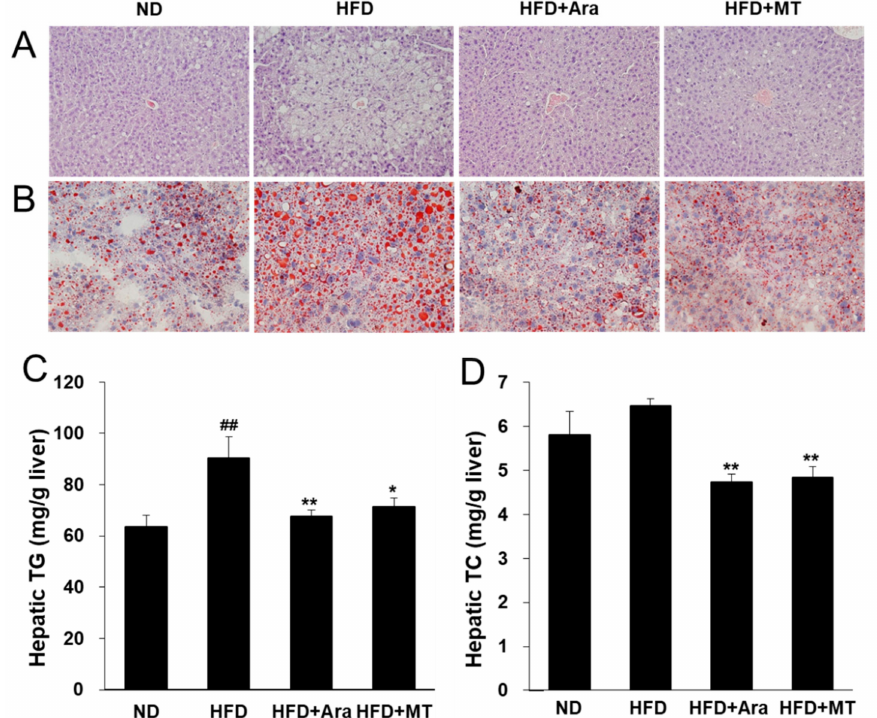
Figure 2. Arazyme reduced hepatic steatosis in HFD-fed NAFLD-like mice. Histology of the livers stained with hematoxylin-eosin (H&E) ( A ) and Oil-red O ( B ) ( × 200 magnification). ( C , D ) Hepatic TG and TC contents. Data are presented as means ± SE ( n = 10). ## p < 0.01 vs. ND; * p < 0.05, ** p < 0.01 vs. HFD by one-way